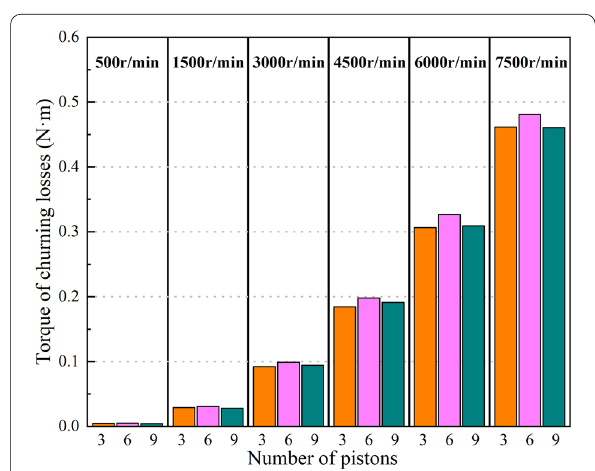
Figure 6 Simulation torque value of churning losses for different numbers of pistons